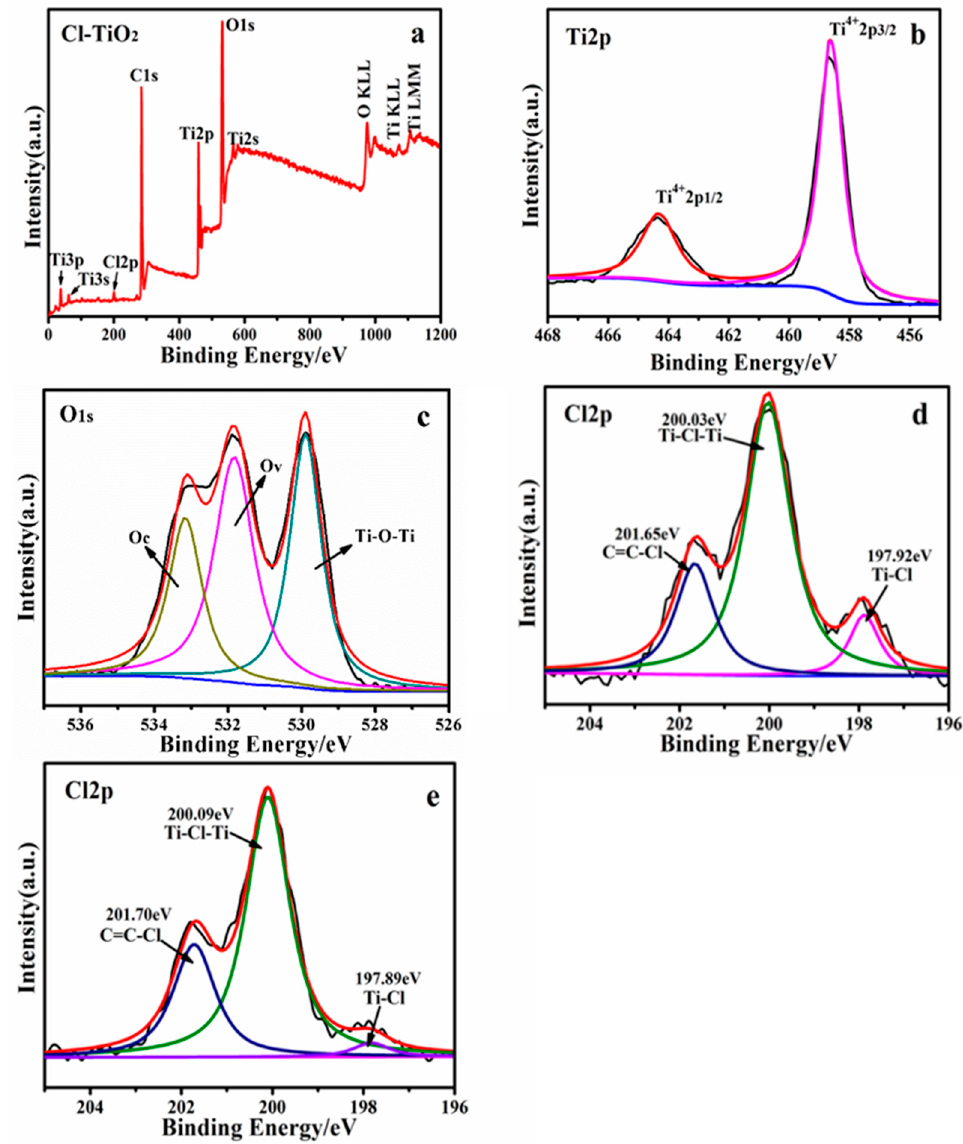
Figure 6. XPS spectra of Cl-TiO 2 : ( a ) survey spectrum, ( b ) Ti 2p spectrum, ( c ) O 1s spectrum, ( d ) Cl 2p spectrum, and ( e ) Cl 2p spectrum after washing with 1M NaOH.